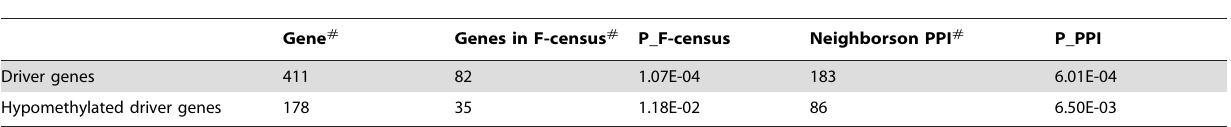
Table 2. The proportion of known cancer genes in our driver genes.